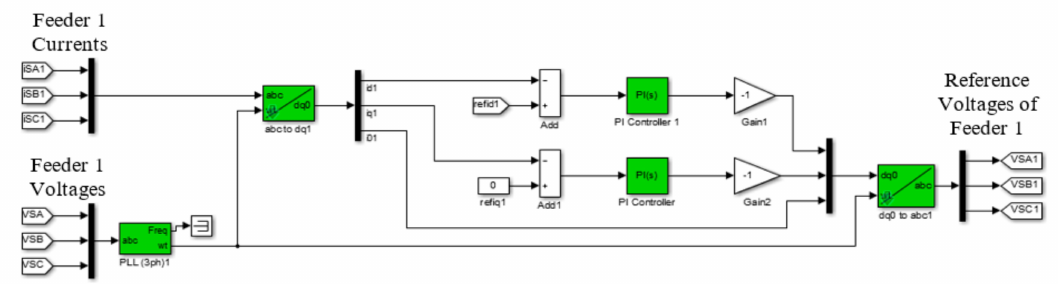
Figure 9. Models for the generation of the reference voltages of feeder 1.